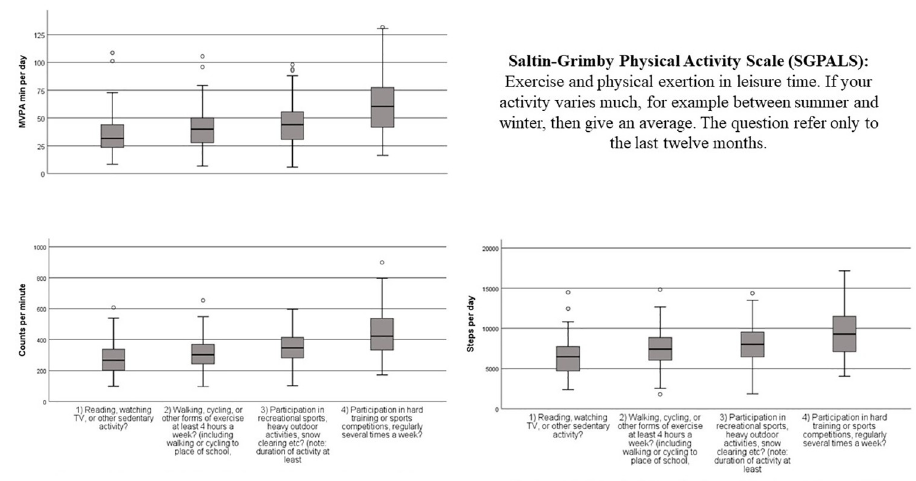
Fig 1. Box plot with median, interquartile range, maximum and minimum with outliers of CPM, steps and MVPA per day by SGPALS ranks. The Fit Futures Study 2010–2011.